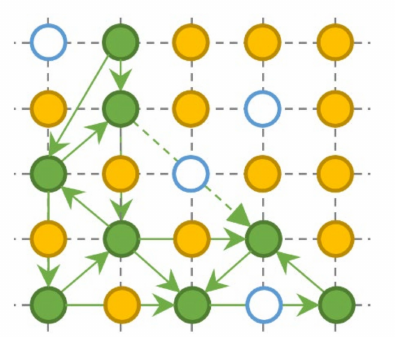
Figure 1. Schematic diagram of the first-level network. The white points are the phase points that are masked due to poor quality, the green points are the first-level points, the corresponding green solid arrow is the Delaunay triangulation formed by the first-level points, and the green dashed arrow is deleted due to the long distance The yellow points are the second-level